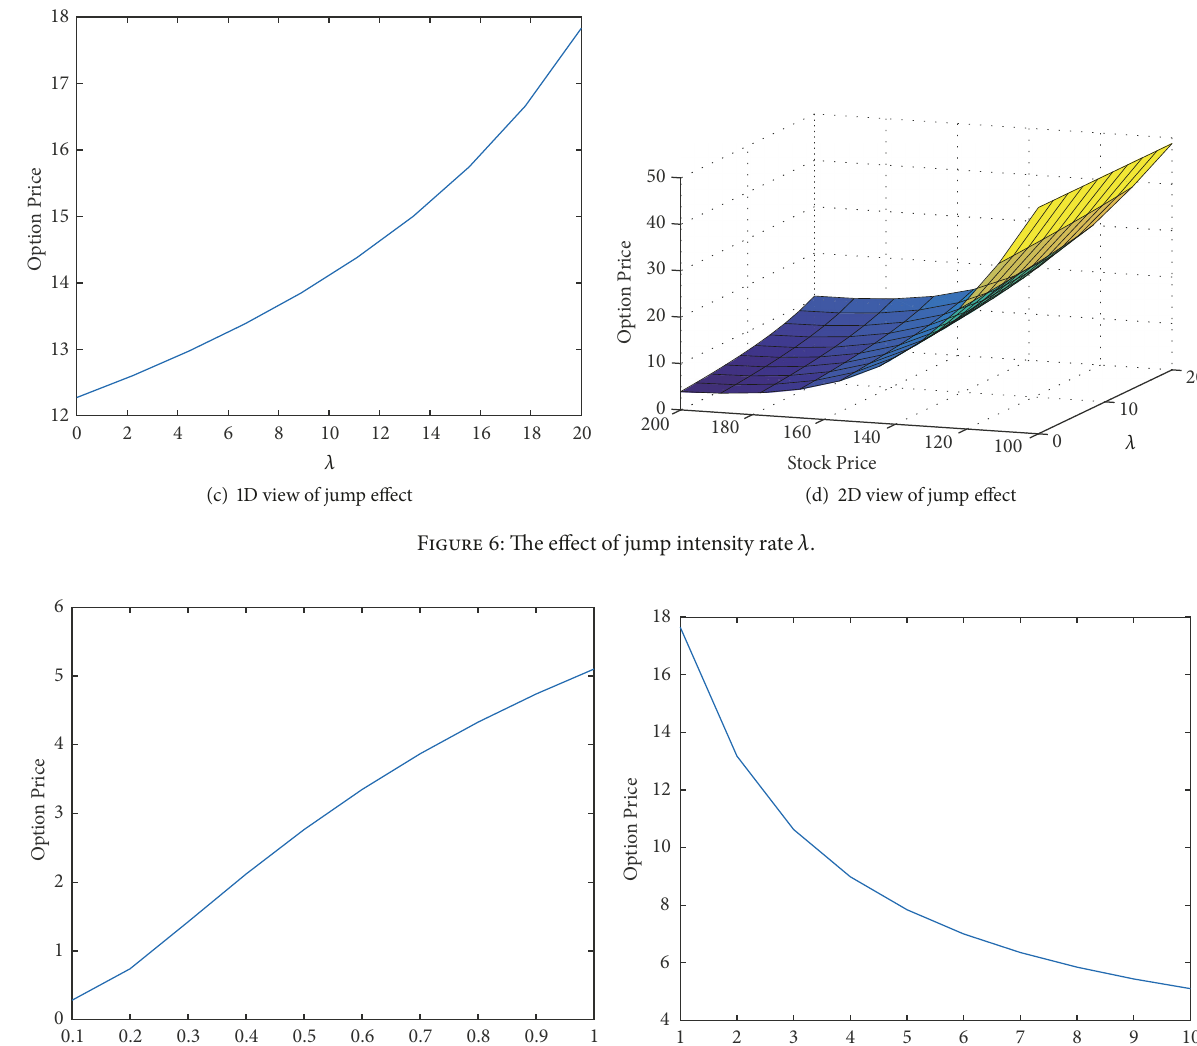
Figure 7: Effects of fast-scale rate and slow-scale